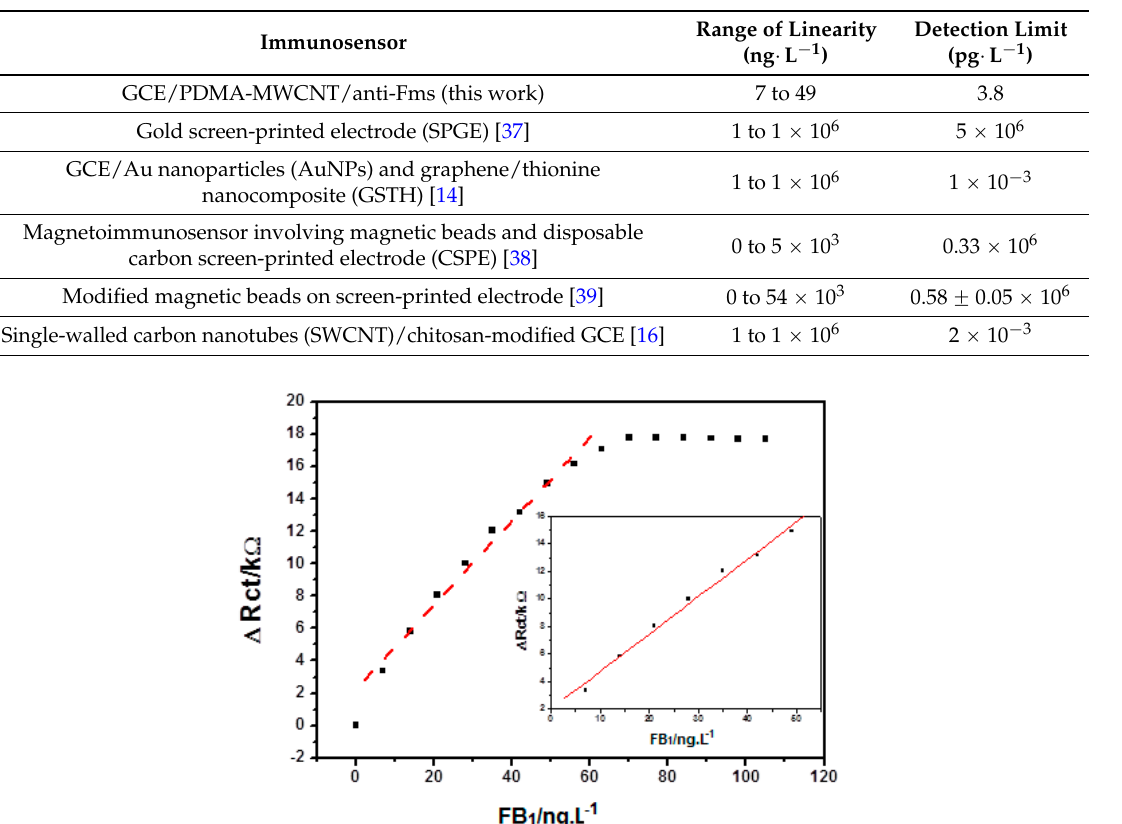
Figure 11. Calibration plots of the GCE/PDMA-MWCNT/anti-Fms immunosensor.